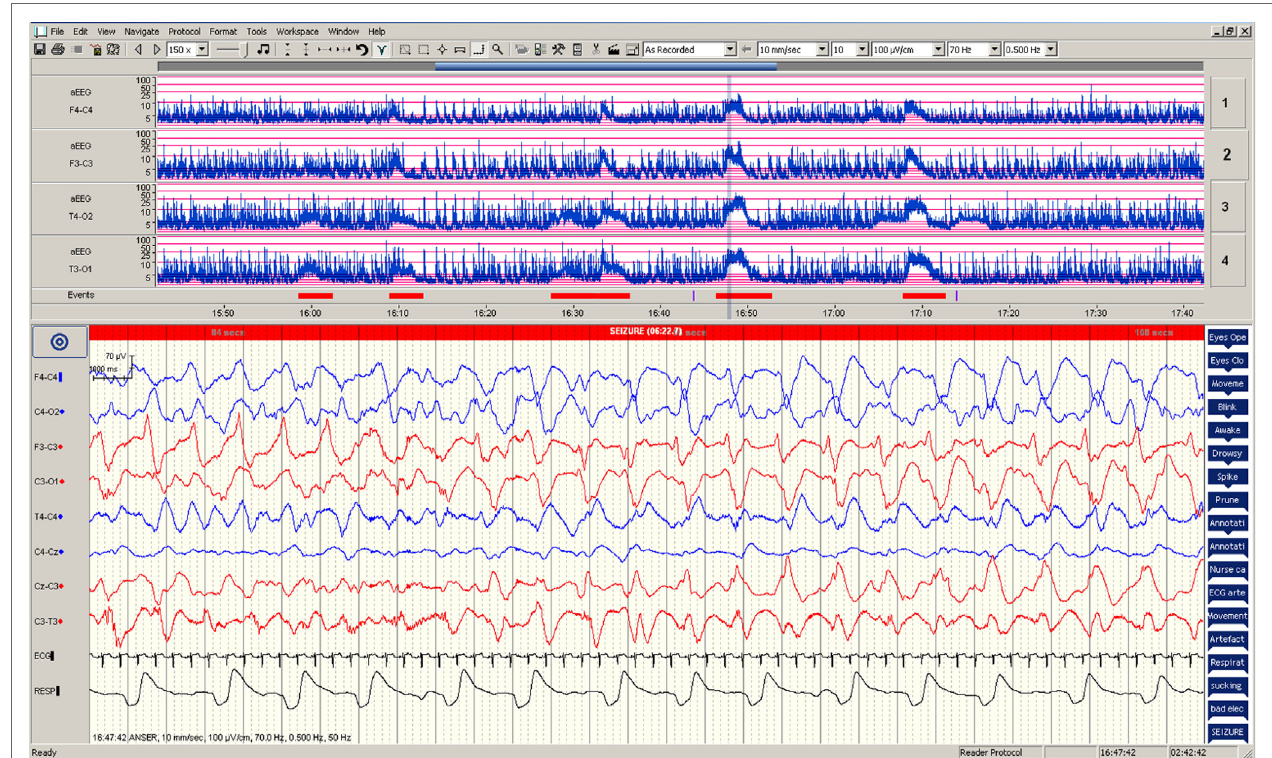
FIGURe 1 | electrographic changes during the seizures . Amplitude-integrated electroencephalogram (aEEG) recording from F4–C4, F3–C3, T4–O2, and T3–O1 are presented in the upper panel with five seizure episodes marked in red. Electroencephalographic (EEG) changes during the fourth seizure are presented in the lower